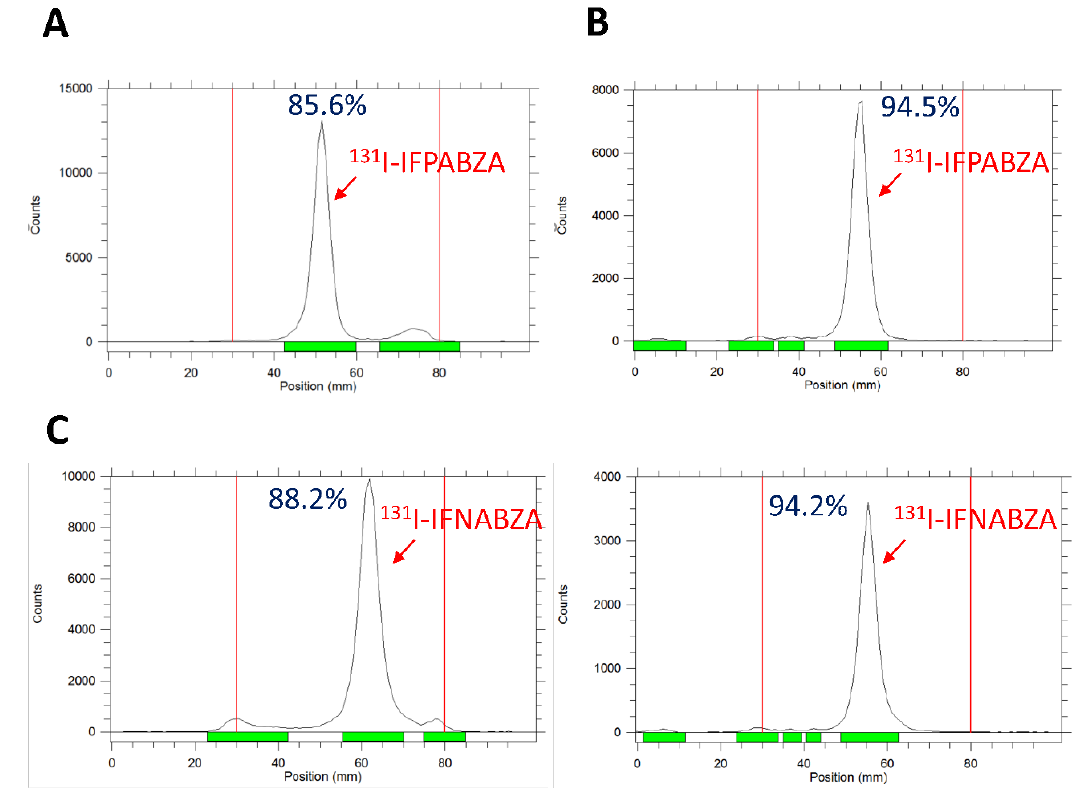
Figure 2 . ( A , C ) Radio thin-layer chromatography analysis of the reaction mixture and ( B , D ) the purified 131 I-IFPABZA and 131 I-IFNABZA. The radiolabeling efficiency and the radiochemical purity was determined by radio-TLC using MeOH/CH 2 Cl 2 = 1:10 ( v / v ) and 1:8 ( v / v ) as eluting agent for 131 I-IFPABZA and 131 I-IFNABZA, respectively.